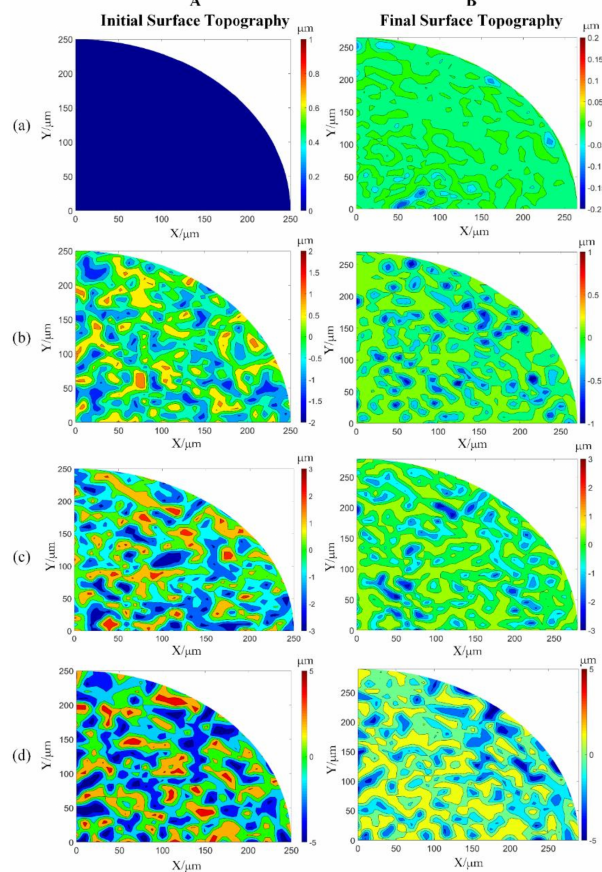
Figure 6. The surface morphology under different initial roughness after micro compression process